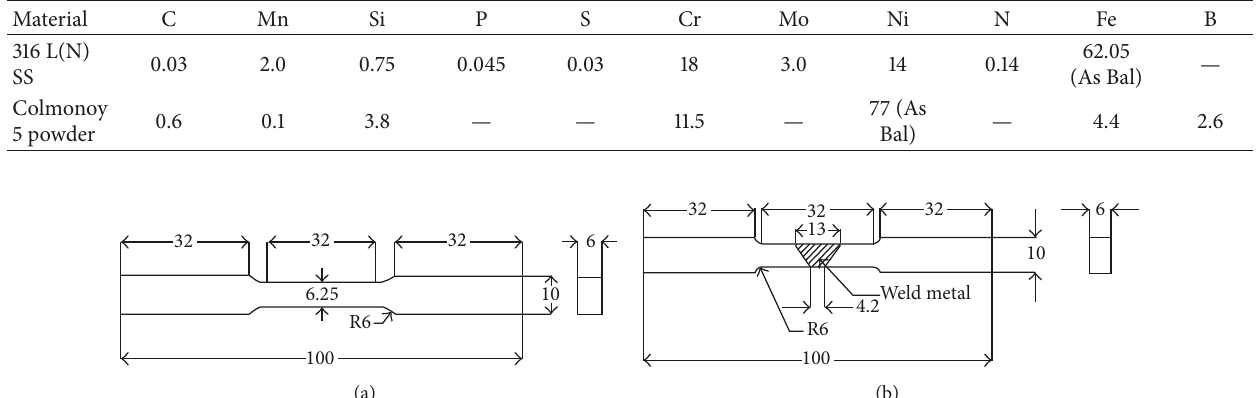
Table 2: Chemical composition of 316 L(N) SS and Colmonoy 5.